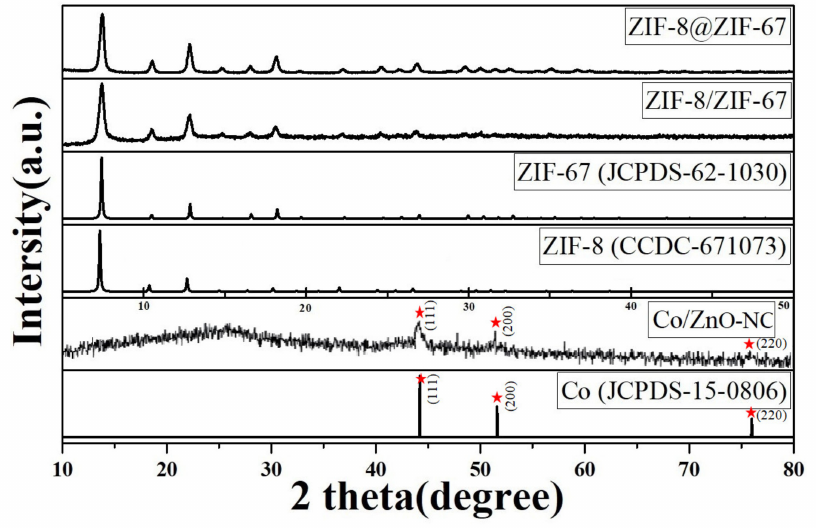
Figure 2. XRD patterns of ZIF-8, ZIF-67, ZIF-8@ZIF-67, ZIF-8/ZIF-67, Co/ZnO-NC, and Co. The red stars in the Figure is